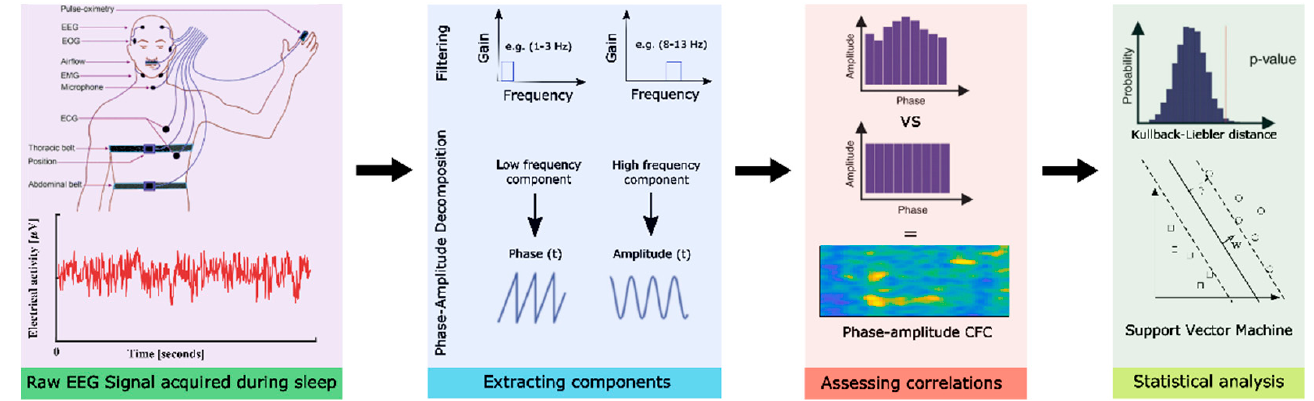
Figure 1. Data acquisition and analysis pipeline overview . Here, the first block represents the data acquisition, second block ‐ EEG data pre ‐ processing, third ‐ computing modulation indices and the fourth block represents the statistical analysis performed.